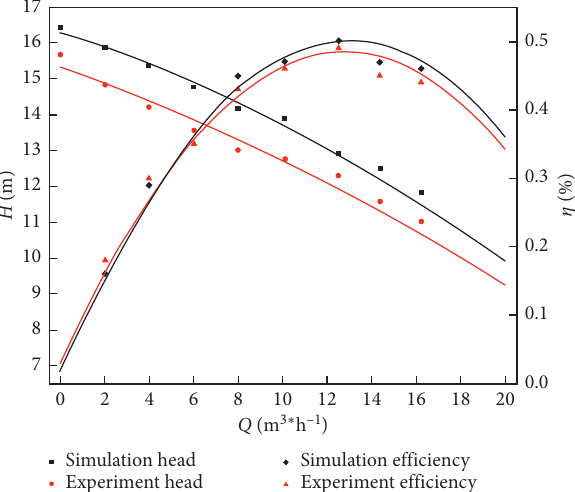
Figure 2: Verification of external characteristics of centrifugal